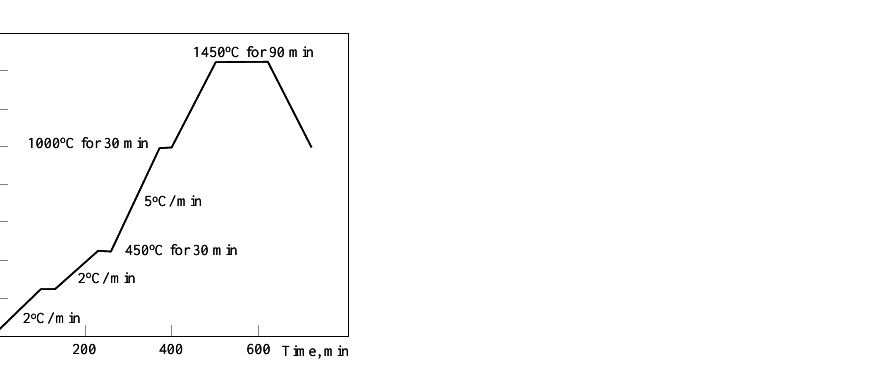
Figure 3. Heat-treatment thermal cycle applied in the compacted cemented carbide sintering pro- cess.